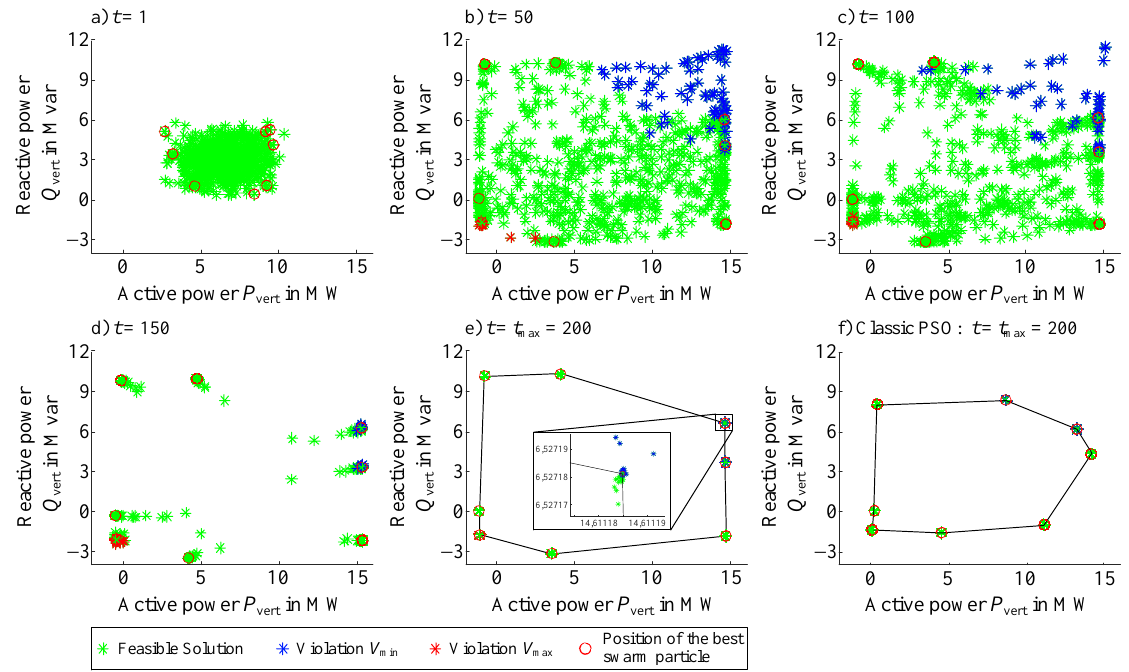
Figure 5. Convergence of the modified PSO ( a – e ) and comparison with the classic PSO ( f ). The eight initial swarms at iteration step t = 1 are gathered in the middle of the PQ-plane. This folding problem is based on the central limit theorem of the probability theory [16], which also occurs at the stochastic approaches for the FOR determination (cf. [15,17]). The particles with the best solution (see red circles in Figure 5a) are already orientated to the corresponding edges of the FOR. During the solution process, the particle swarm moves through the PQ-plane searching for a new x gb . Thereby the solution search becomes increasingly local. Within the solution process a variety of particles with a violation of the voltage limits occur especially at areas with a high, uniformly directed P vert and Q vert , respectively, to the lower-level grid. For sampling points in these areas the swarm does not converge in a uniform result (see close up in Figure 5e). This leads to small deviations of the FOR at each run of the modified PSO. The modifications of the PSO lead to significantly better results for all sampling points. For example the deviations of the upper left sampling points are ∆ P vert = − 1.10 MW and ∆ Q vert = 2.13 Mvar. The area